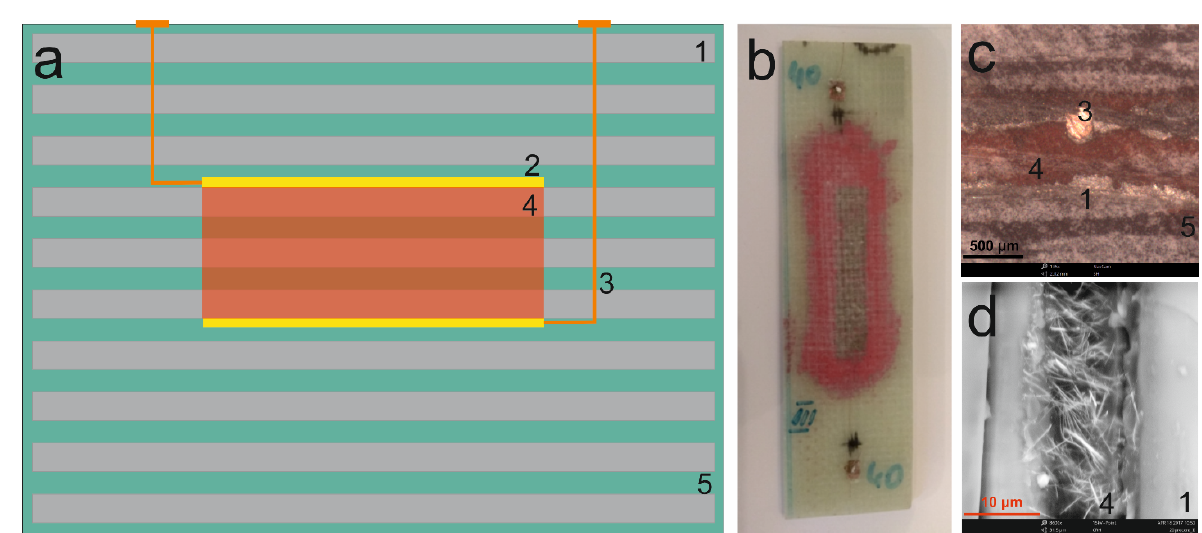
Figure 6. ( a ) Diagram depicting the scheme for the FRP laminate with built-in strain sensor and ( b ) a photograph of the synthesized laminate. ( c , d ) SEM images of the cross-section of the FRP laminate. Here, 1—plain-woven glass fabric, 2—silver electrodes, 3—copper wires, 4—epoxy resin/SbSI composite active layer, and 5—epoxy resin.